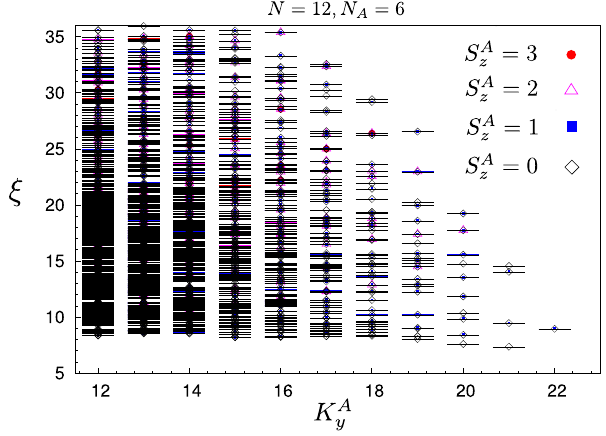
FIG. 8. PES of the spin-singlet Gaffnian state for N ¼ 12 particles and N ϕ ¼ 12 flux quanta on an open cylinder with aspect ratio equal to 1. The spectrum is obtained by tracing out N N 6 particles and plotted as a function of momentum B ¼ A ¼ K A A . Different values of S A z component of spin y in part z , the total in part A , are indicated in the